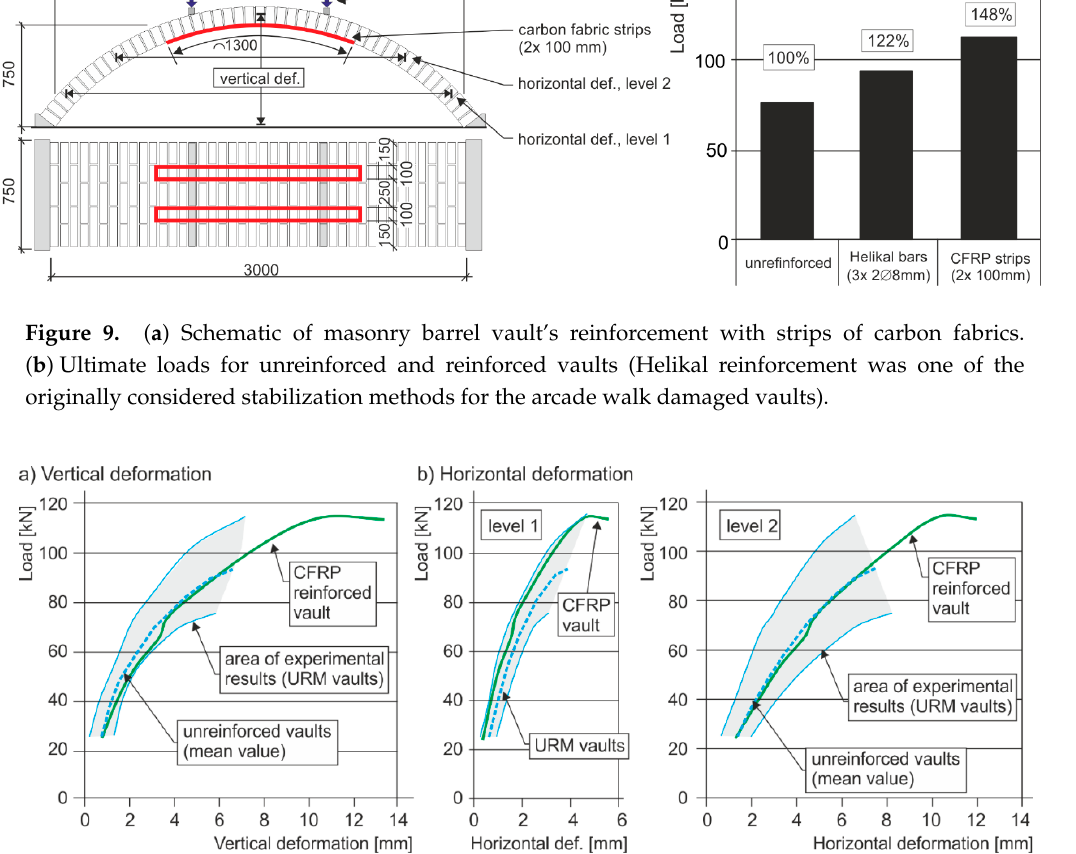
Figure 10. Load vs. vertical ( a ) and horizontal ( b ) deformation graphs for unreinforced and CFRP reinforced vaults.